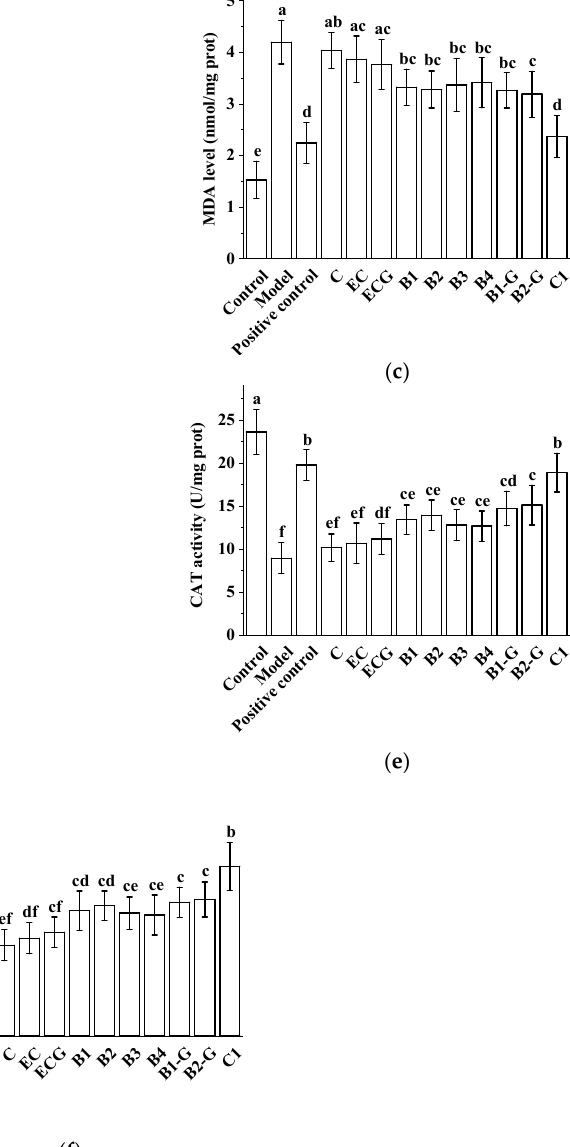
Figure 7. Effects of procyanidins with different structures on oxidative stress in zebrafish treated with H 2 O 2 . ( a ) Representative fluorescence photomicrographs of zebrafish; ( b ) ROS levels; ( c ) MDA levels; ( d ) GSH-Px activity; ( e ) CAT activity; ( f ) SOD activity. Data are expressed as the mean ± SD. Control, Blank control group; Model, H 2 O 2 (300 μ M); Positive control, NAC (30 μ M) + H 2 O 2 (300 μ M); C, C (25 μ M) + H 2 O 2 (300 μ M); EC, EC (25 μ M) + H 2 O 2 (300 μ M); ECG, ECG (25 μ M) + H 2 O 2 (300 μ M); B1, B1 (25 μ M) + H 2 O 2 (300 μ M); B2, B2 (25 μ M) + H 2 O 2 (300 μ M); B3, B3 (25 μ M) + H 2 O 2 (300 μ M); B4, B4 (25 μ M) + H 2 O 2 (300 μ M); B1-G, B1-G (25 μ M) + H 2 O 2 (300 μ M); B2-G, B2-G (25 μ M) + H 2 O 2 (300 μ M); C1, C1 (25 μ M) + H 2 O 2 (300 μ M). All experiments were conducted three times. Values with different letters are significantly different ( p < 0.05, one-way ANOVA).